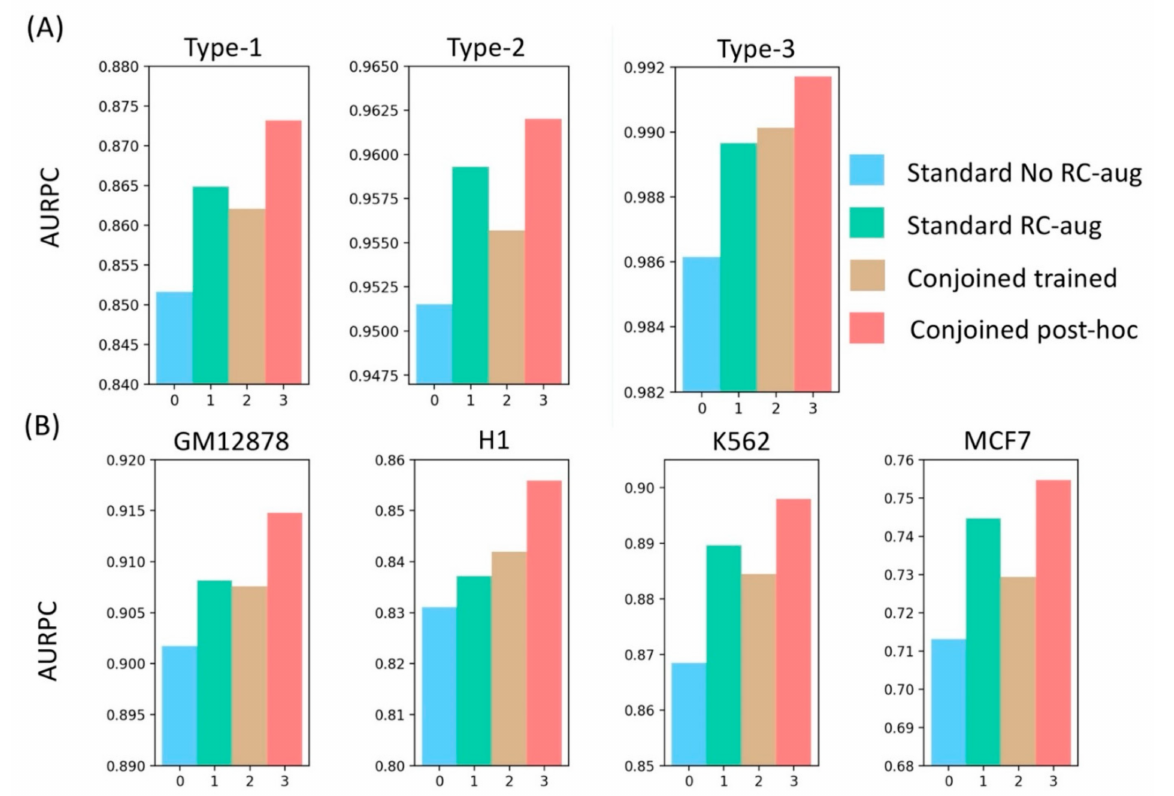
Figure 4. Benchmarking reverse-complement tackling strategies used in deep learning models in genomics on ( A ) different types of non-anchors and ( B ) different cell-lines using AUPR, indicating the superior performance of conjoined post-hoc models compared to other